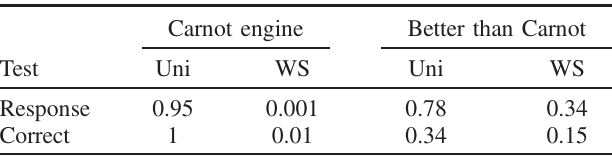
TABLE III. Fisher ’ s exact test. School 1 versus school 2. Results are p values from Fisher ’ s exact tests comparing the students ’ responses from the two schools: p > 0 . 10 is considered statistically similar. Tests were done on the entire distribution of responses as well as on the distribution if all incorrect responses were